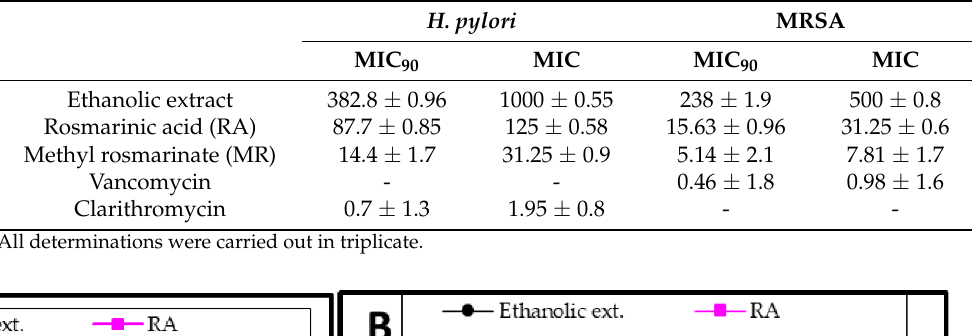
Table 2. Mean MIC ( µ g/mL ± SD) values of Cordia africana Lam. stem bark ethanolic extract and the isolated rosmarinic acid (RA) and methyl rosmarinate (MR) against H. pylori and methicillin-resistant Staphylococcus aureus (MRSA).